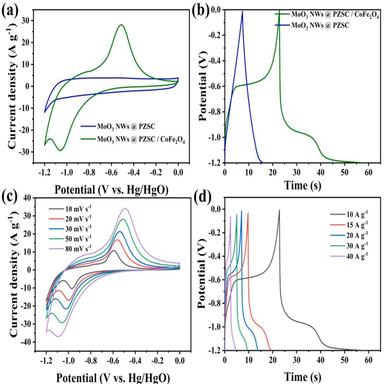
(a) CV curves scan at 50 mV s −1 of MoO3 NWs @ PZSC/ CoFe2O4 and MoO3 NWs @ PZSC. (b) GCD curves at 10 A g−1 of MoO3 NWs @ PZSC/ CoFe2O4 and MoO3 NWs @ PZSC. (c) CV curves with various scan rates of MoO3 NWs @ PZSC/ CoFe2O4. (d) GCD curves with various current densities of MoO3 NWs @ PZSC/ CoFe2O4.